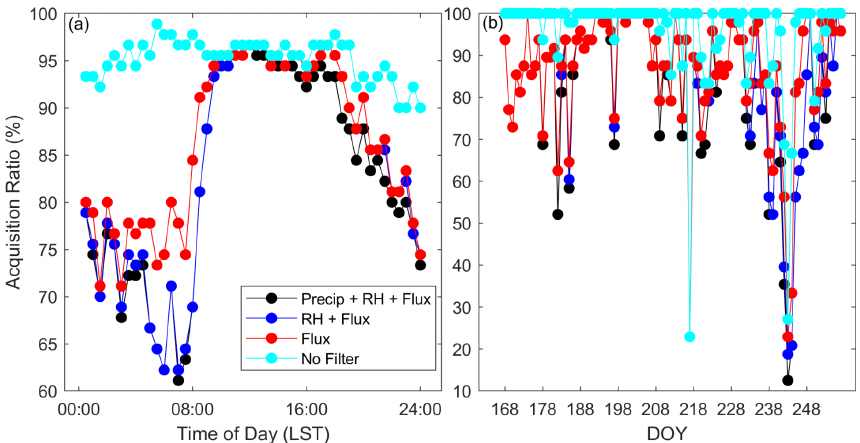
Figure 1. Screening effects on the data acquisition ratio (AR) as a function of (a) diel cycle and (b) day of year. Precip + RH + Flux shows AR after all filtering has been completed, RH + Flux indicates AR after RH threshold and steady-state turbulence tests, and Flux denotes AR after only turbulent tests.